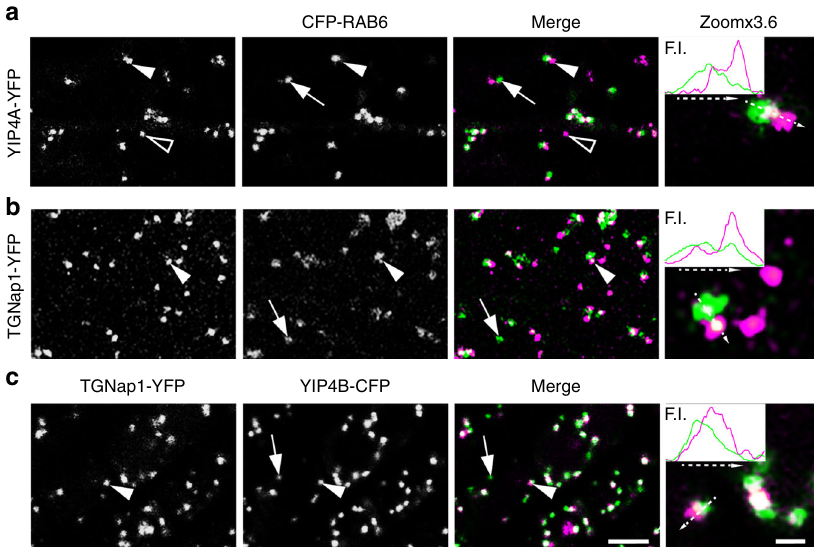
Fig. 4 TGNap1 partially colocalizes with Rab6 and YIP4 at the TGN. a Confocal images of cotyledon epidermal cells expressing YIP4A-YFP and CFP-Rab6 showing co-distribution to the same organelles (arrowheads) or distinct organelles (arrow: Rab6-only positive organelle, likely Golgi stack (see Supplementary Fig. 7); empty arrow: YIP4A-only positive organelle). Insets: line intensity pro fi le (F.I.) along the arrow on the TGN structure. Scale bars = 5 µ m (main images), 1 µ m (zoomed panels.) b , c Confocal images of cotyledon epidermal cells expressing TGNap1-YFP and either CFP-Rab6 ( b ) or YIP4B-CFP ( c ) showing a shifted distribution of TGNap1 vs. either Rab6 or YIP4 (arrowheads). Magni fi cation is presented in Zoomx3.6 panels. Insets: line fl uorescent intensity pro fi le (F.I.) along the arrows with dashed lines drawn on TGN. Arrows: Rab6 ( b ) or YIP4 not colocalizing structures with TGNap1-YFP ( c